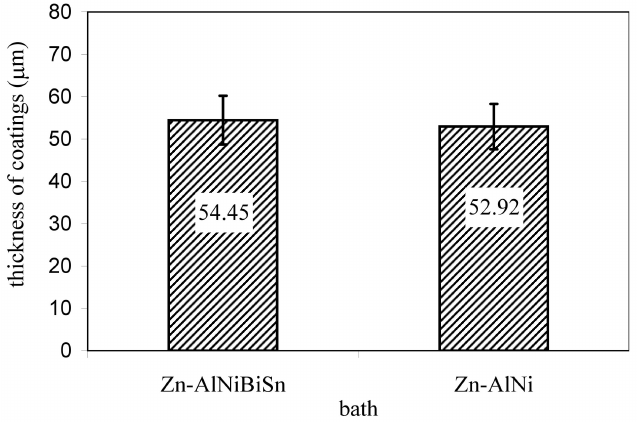
Figure 3. Average thickness of Zn-AlNiBiSn and Zn-AlNi coatings; immersion time 180